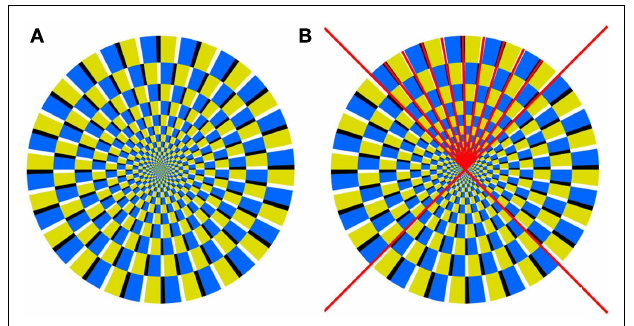
FIGURE 1 | (A) The basic pattern used in Experiment 1.This pattern appears to rotate counterclockwise. (B) The auxiliary radii lines, shown in red in the top